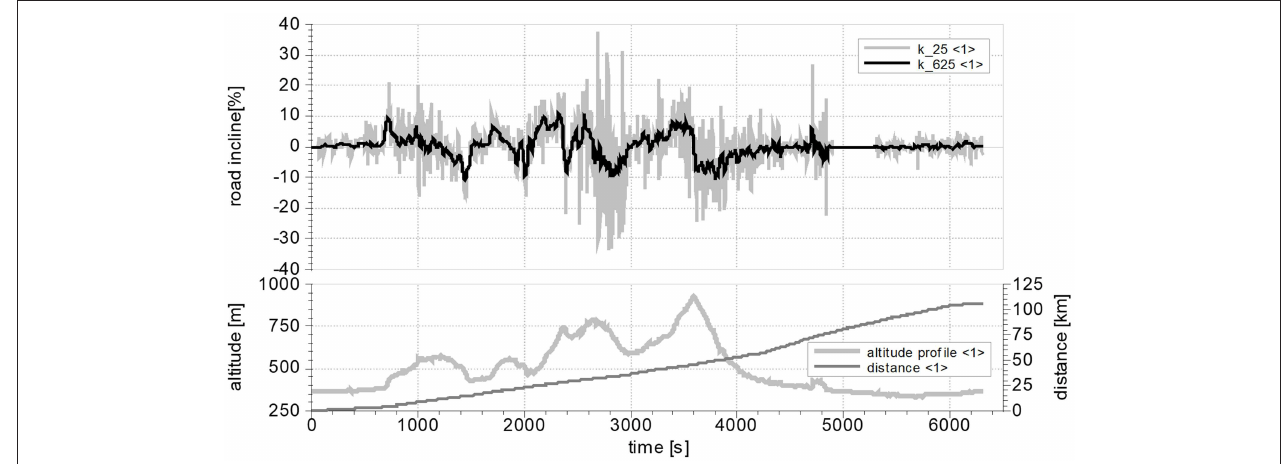
FIGURE 5 | Comparison length distance